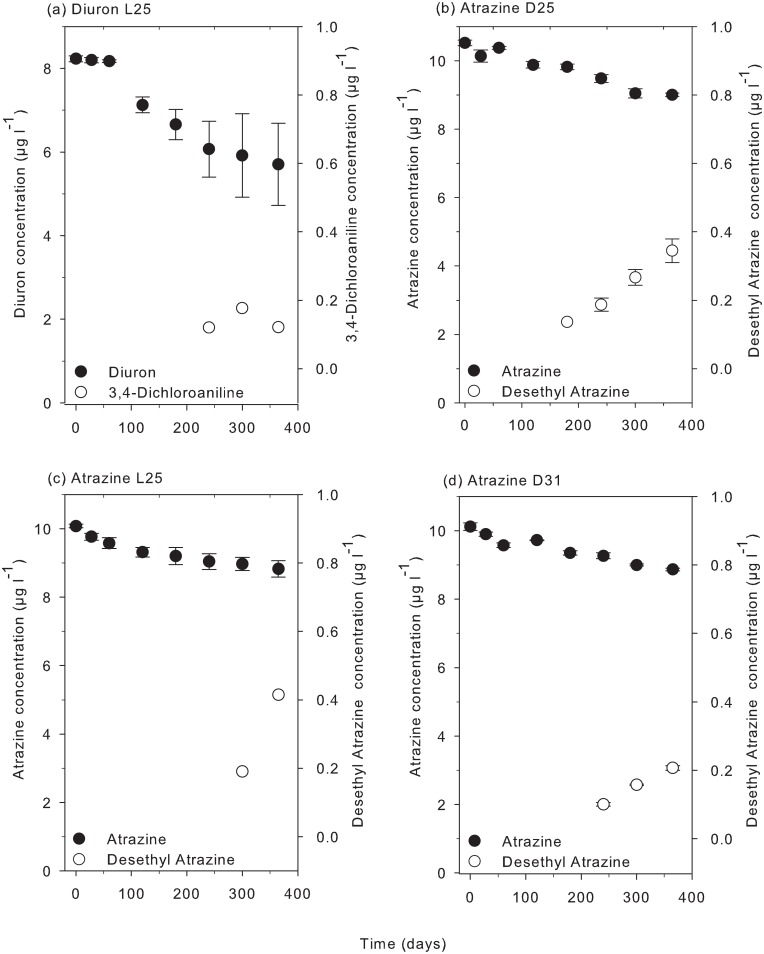
Concentration of metabolites of diuron and atrazine.Concentrations of individual herbicides including measured metabolites (a) diuron light 25°C, (b) atrazine dark 25°C, (c) atrazine light 25°C, and (d) atrazine dark 31°C, over 365 days. Bars represent ± SE. Note the concentration scales for the parent and metabolite are on opposite sides of each graph.